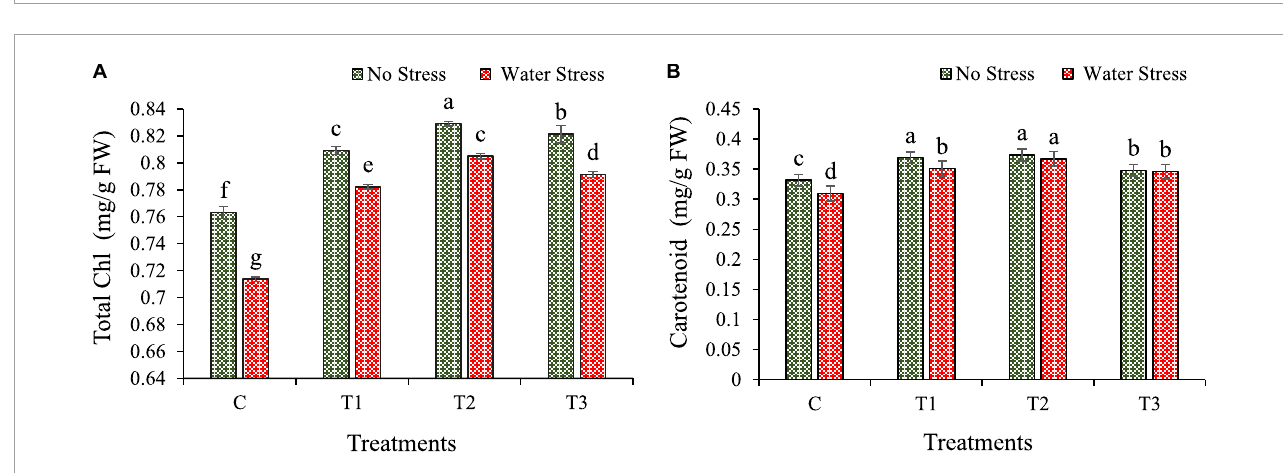
FIGURE5 Impacts of bacterial treatments (T1 — Enterobacter cloacae BHUAS1, T2 — Bacillus megaterium BHUIESDAS3, and T3 — Bacillus cereus BHUAS2) on various biochemical contents of wheat plants under the influence of water-induced drought stress (A) total chlorophyll and (B) carotenoid. The different alphabets indicate statistically significant differences between each treatment (DMRT p <